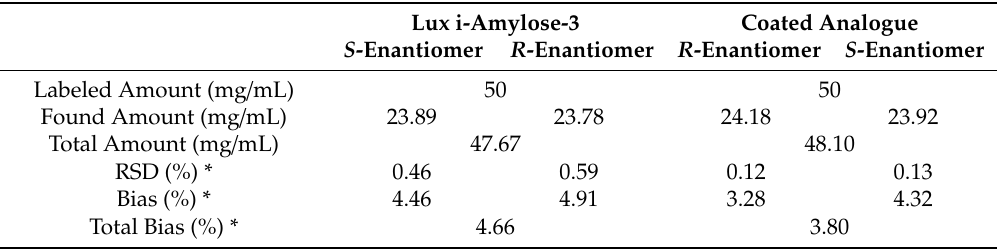
Figure 4. The results of chromatographic analysis of racemic ketoprofen 50 mg / mL injectable solution with both methods. Separation temperature was 35 ◦ C, flow rate was 2 mL / min, detection was performed at 254 nm with the mobile phase composition of n-hexane:ethanol:formic acid, 95:5:0.1 ( v / v / v ) for coated ( a ) and n-hexane:ethanol:formic acid, 98:2:0.1 ( v / v / v ) for immobilized ( b ) chiral selector. Table 3. The results of chromatographic analysis of racemic ketoprofen.